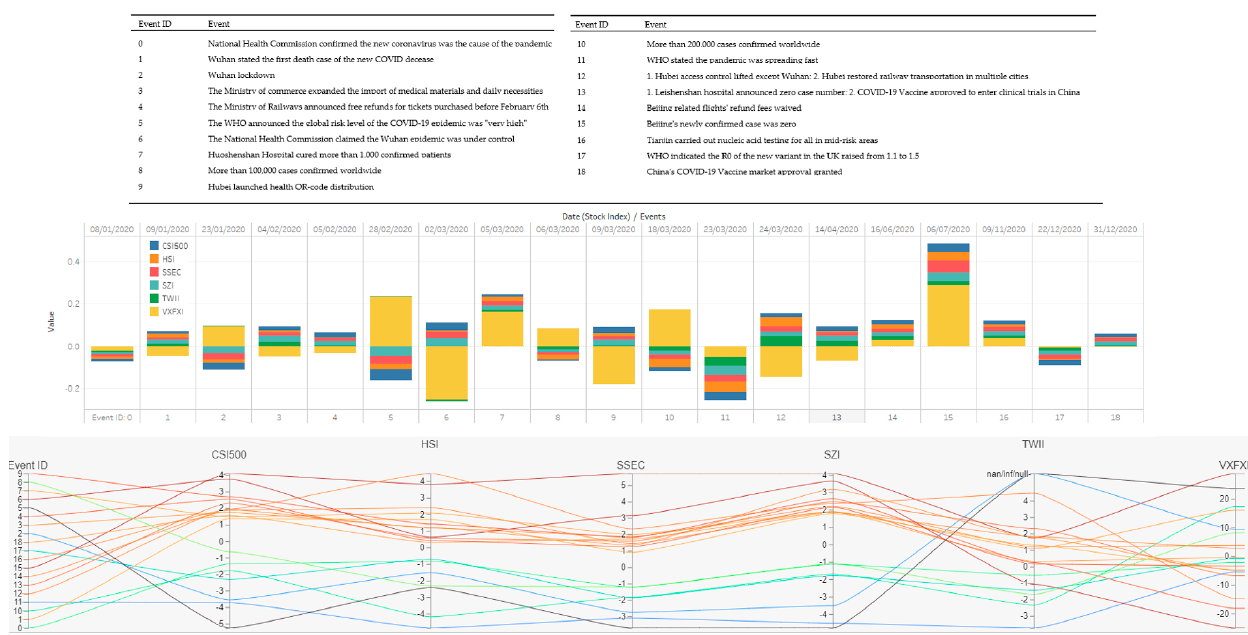
Figure 1. A dashboard of the key COVID-19 events and major stock market indices trends in China. (Six colours represent six stock indices, explained in the middle plot, colour representation remains the same in Figures 2–9).